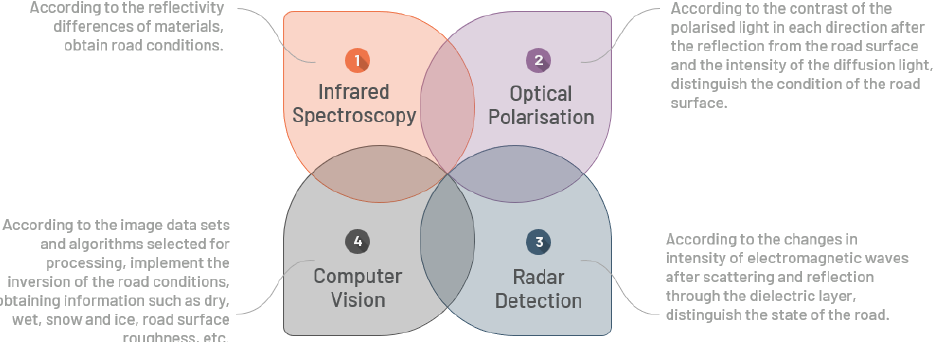
Figure 3. Principles of four non-contact RSC detection